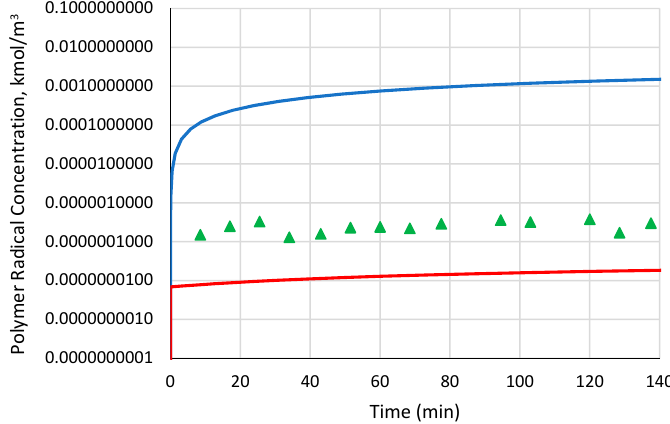
Figure 9. Comparison of experimental [13,15] and calculated profiles of polymer radical concentration versus time for the dithiolactone-mediated free-radical polymerizations (DTLMP) of styrene using DTL1: overall polymer radical (blue solid line); polymer radicals excluding P s DTL • (red solid line); experimental data (green triangles). Monomer:controller:initiator: 300:2:1.